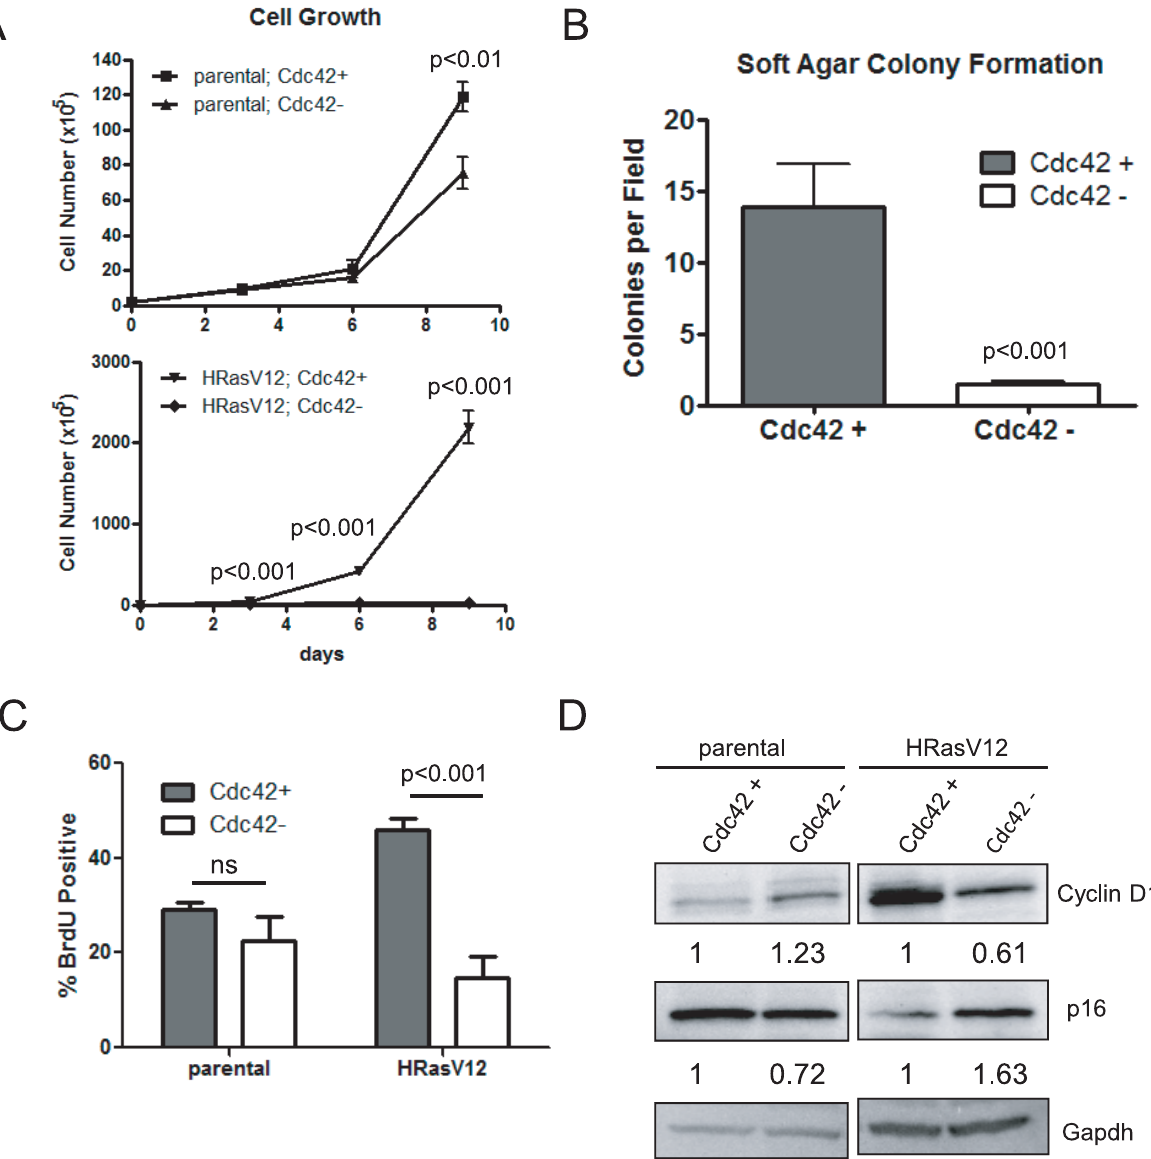
Figure 3. Loss of Cdc42 in HRasV12 transformed cells results in reduced cell proliferation and anchorage-independent growth. ( a ) Equal cell numbers were plated following cdc42 deletion and cells were counted by trypan blue exclusion every three days for 9 days. Curves represent at least two independent experiments performed in triplicate. ( b ) Cdc42-proficient and –deficient HRasV12 cells were grown in a 0.3% agarose solution. Experiments were performed in triplicate and 9 independent fields were counted for colonies. ( c ) Exponentially growing cells were pulsed with 5-bromodeoxyuridine (BrdU) for 1 hr. prior to harvest. Cells were stained with anti-BrdU and propidium iodide (PI) and analyzed by flow cytometry. Graphs represent at least three independent experiments. ( d ) Cell lysates were immunoblotted for the cell cycle regulators, Cyclin D1 and p16 ink4a . Gapdh served as a loading control.